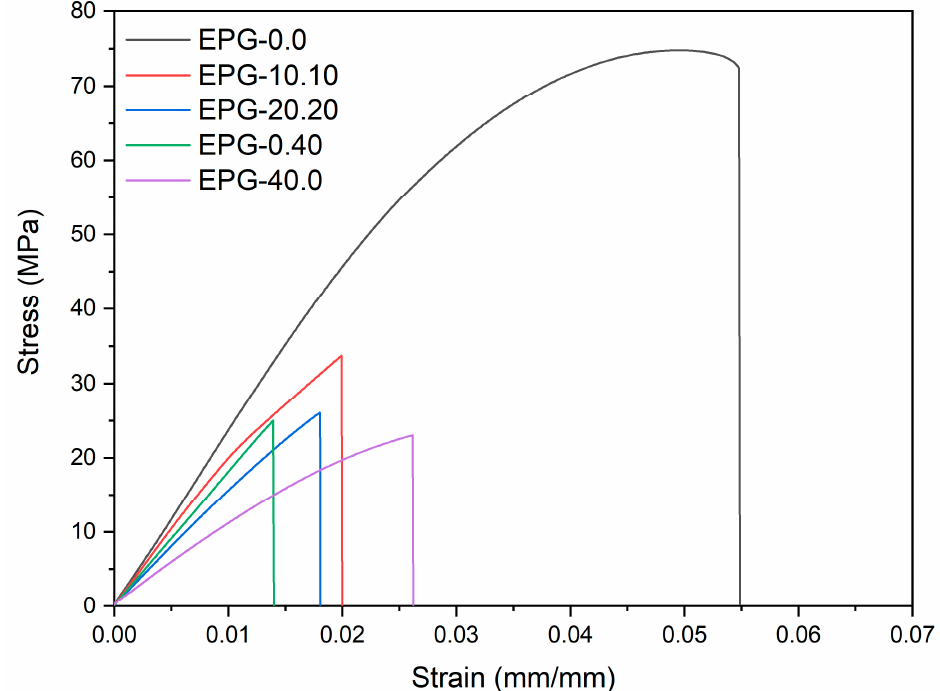
Figure 2. Representative stress–strain curves from quasi-static tensile tests of five selected syntactic foams.